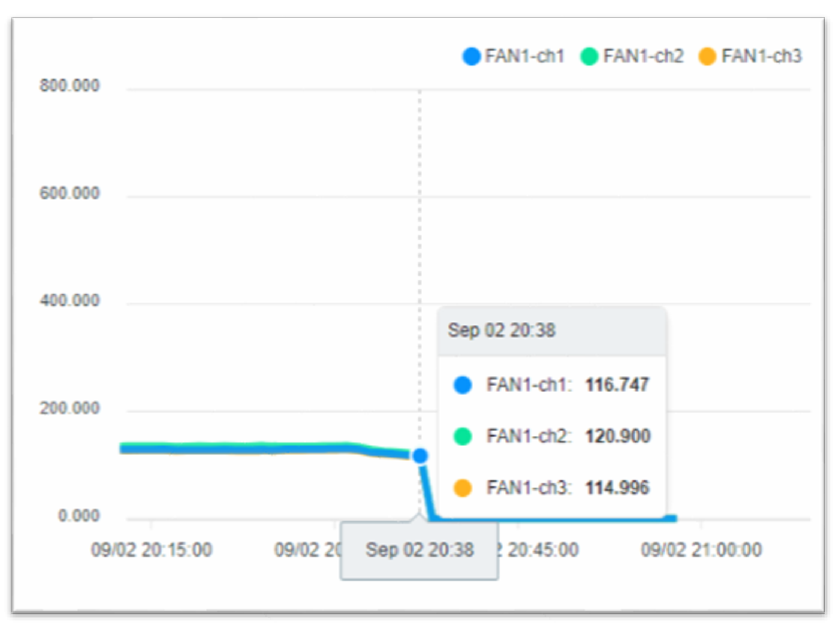
Figure 13. The System of Fan Start.